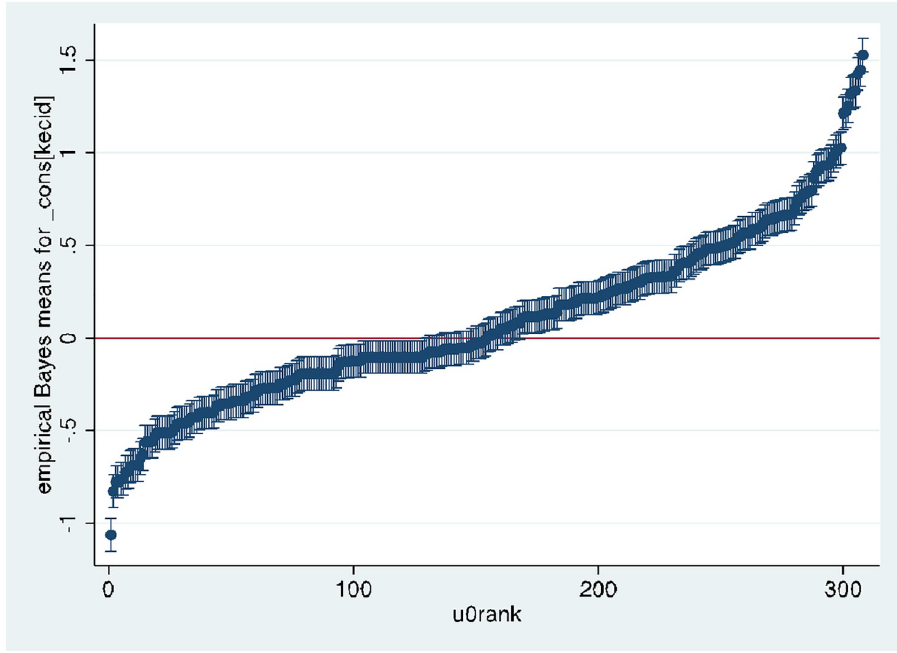
Fig 2. Sub-districts caterpillar